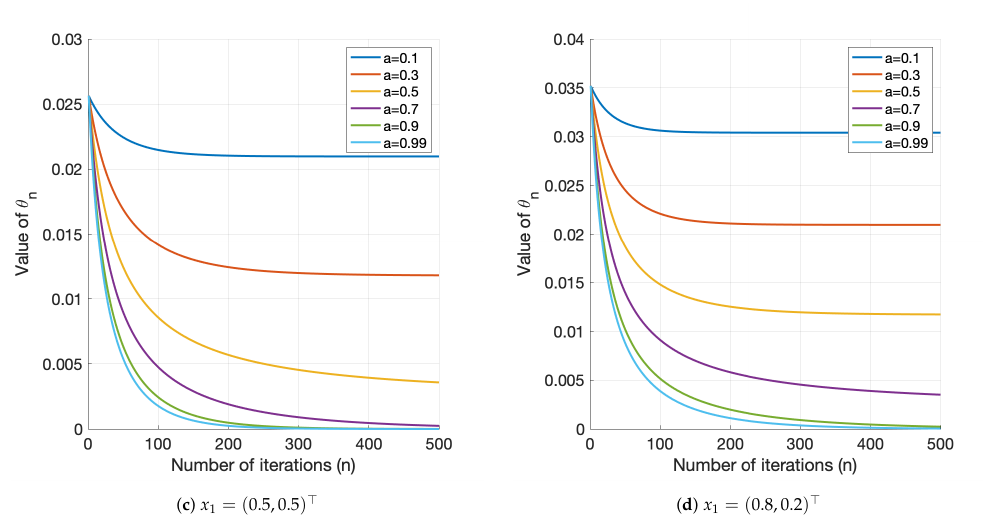
Figure 4. The behavior of the function value θ n for different values of the initial point x 1 when performed by APGM with various values for a .